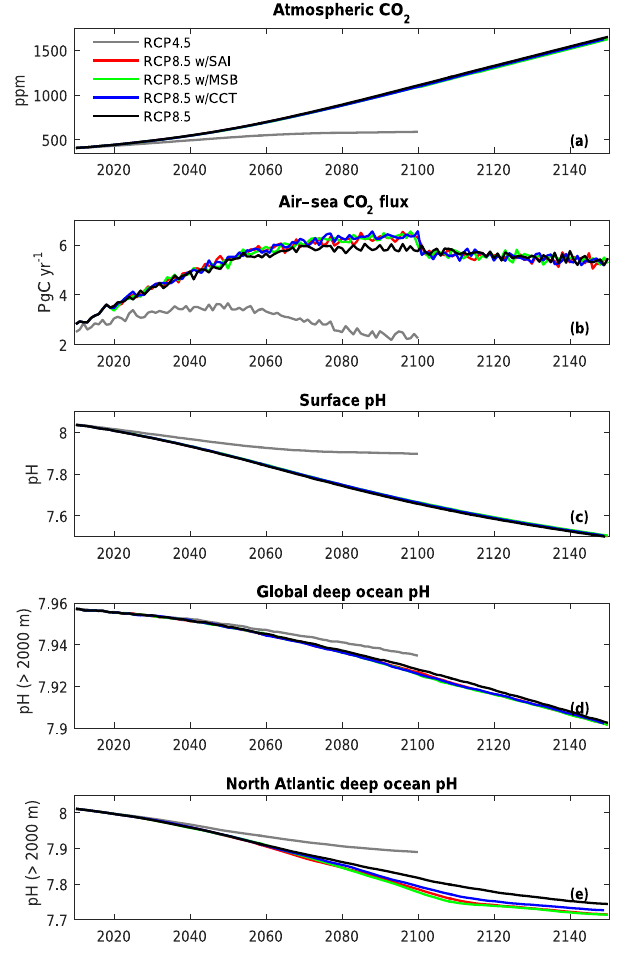
Figure 4. Time series of global average change in (a) atmospheric CO 2 (ppm), (b) air–sea CO 2 flux (PgCyr − 1 ) , (c) global surface ocean pH, (d) global deep ocean (>2000m) pH, and (e) deep (>2000m) North Atlantic Ocean (north of 30 ◦ N) pH.